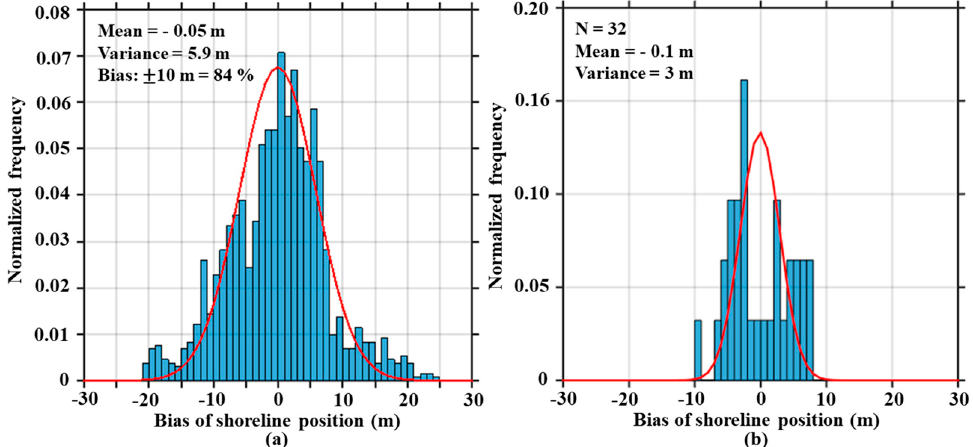
Figure 25. ( a ) A histogram of the bias between the survey and mTWM-detected shoreline positions during 2005–2008 (1 m bins) with the normal adjusted curve super-imposed in red. ( b ) A histogram of the bias between the estimated shoreline positions with the survey and only Garcia’s filling method (1 m bins) with the normal adjusted curve superimposed in red.